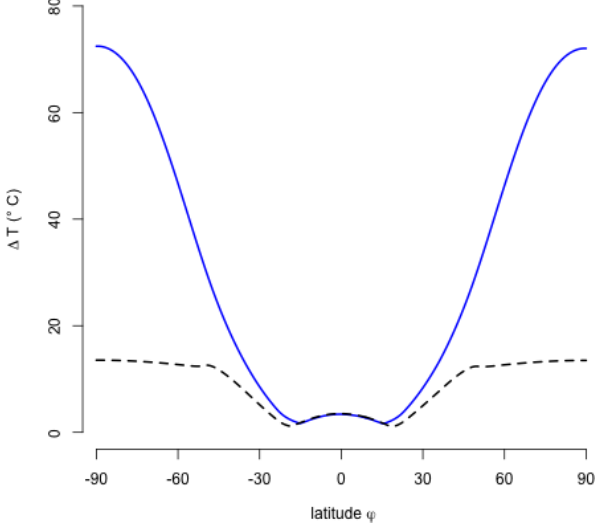
Figure 5. Temperature depending on C p when solving (Eq. 9) nu- merically. The reference heat capacity is the atmospheric heat ca- pacity C a p = 1 . 02 × 10 7 JK − 1 m − 2 . The climate is insensitive to